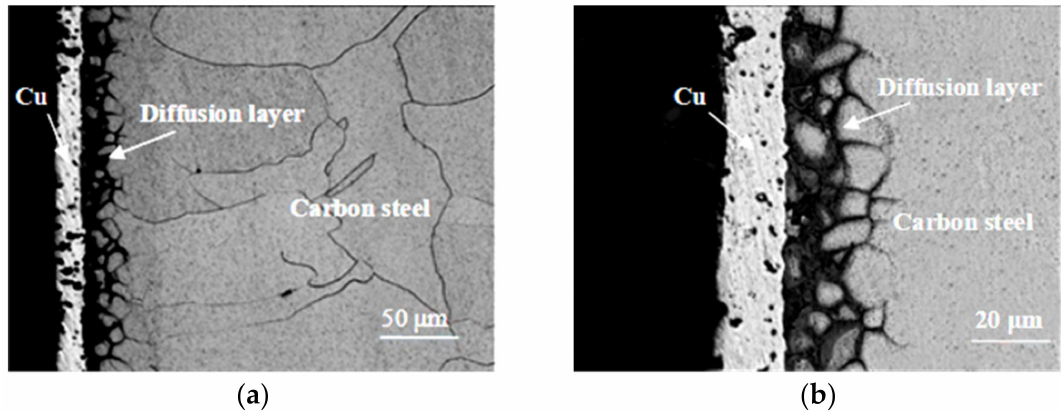
Figure 2. Microstructure of Cu − Fe ( a ) Carbon steel and diffusion layer and ( b ) Diffusion